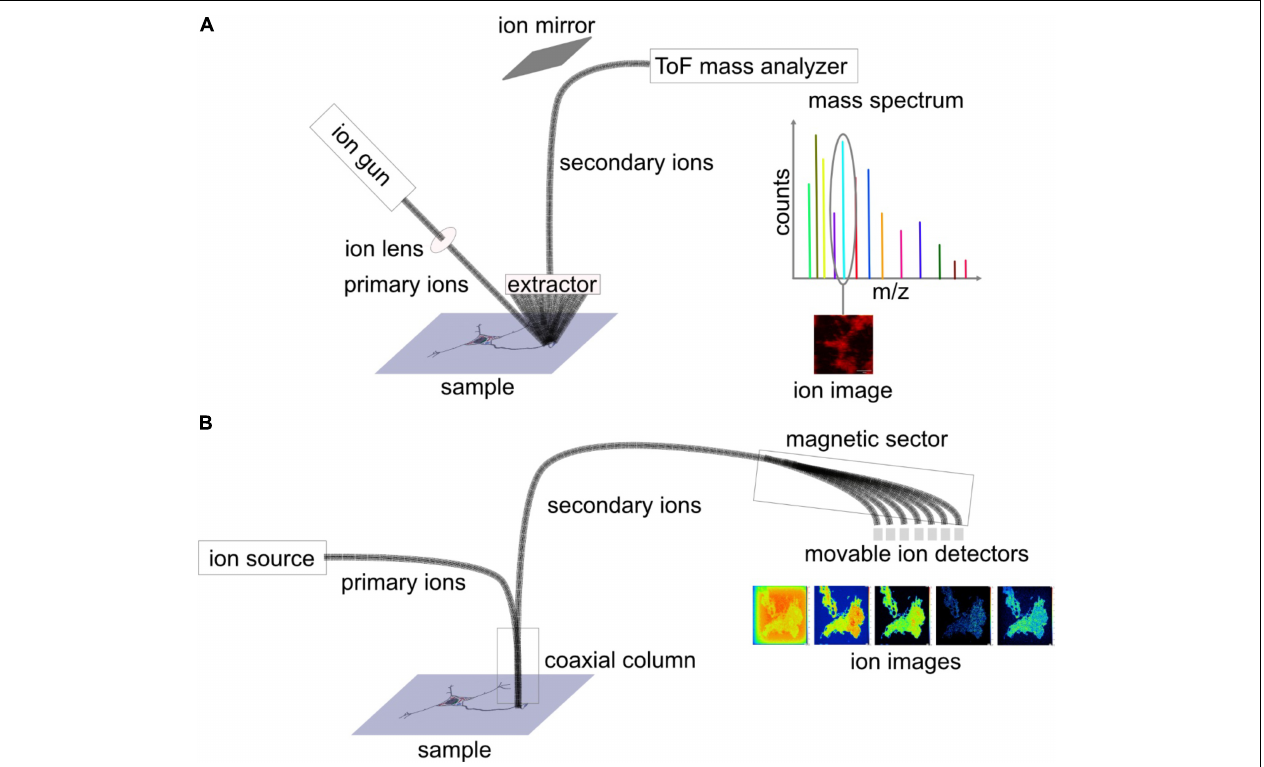
FIGURE 2 | Schematic diagram depicting the set-up of (A) ToF-SIMS and (B) nanoscale SIMS (NanoSIMS). In ToF-SIMS, sample surface is bombarded with primary ion beam at an angle of 45 degrees, and secondary ions are sputtered away, extracted, and transferred into the ToF mass analyser, where the ions are separated based on their mass to charge ratio (m/z). For each pixel, a mass spectrum is obtained, and for each mass peak, an ion image is depicted. NanoSIMS can achieve higher lateral resolution owing to the coaxial design of the primary and secondary ion beams. After being sputtered from the sample surface, the secondary ions are separated by a magnetic sector analyzer, and, eventually, seven masses are